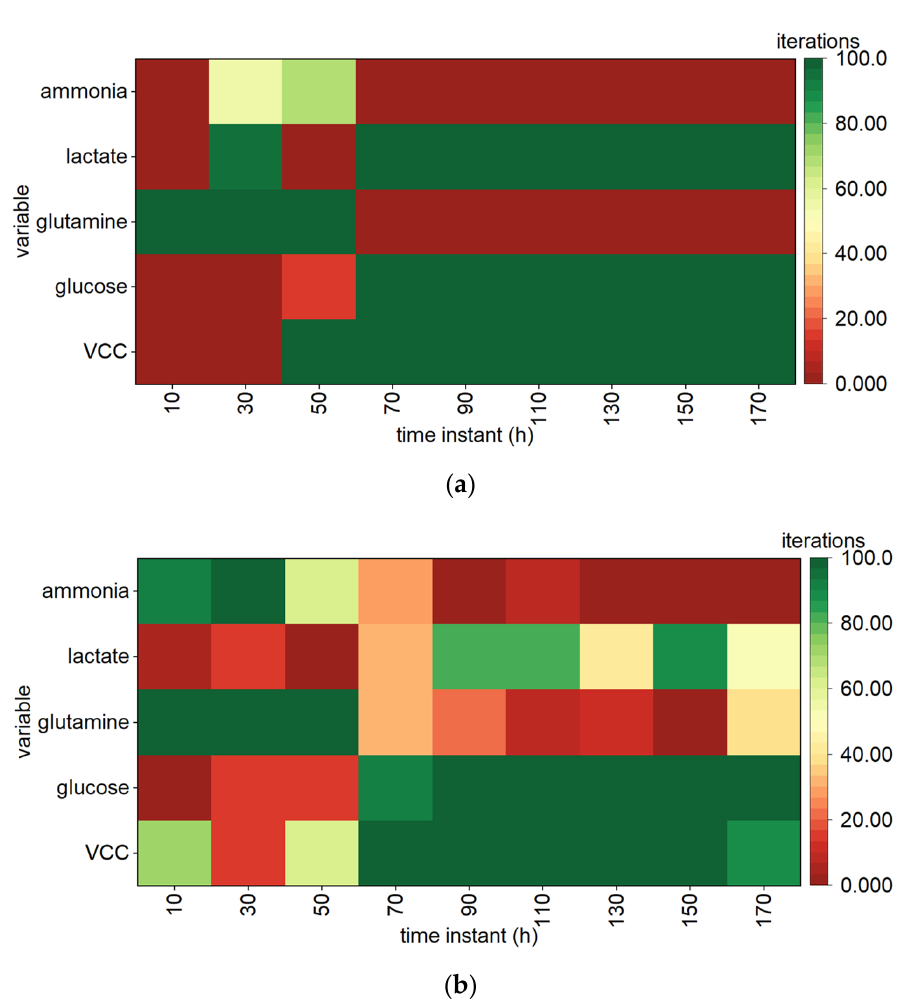
Figure 7. Process understanding for mAbs titer estimation through MPLS variable importance at each time point selection frequency: ( a ) MPLS model calibrated with 80 process batches, and ( b ) MPLS model calibrated with 8 process batches, randomly extracted from X PC and y